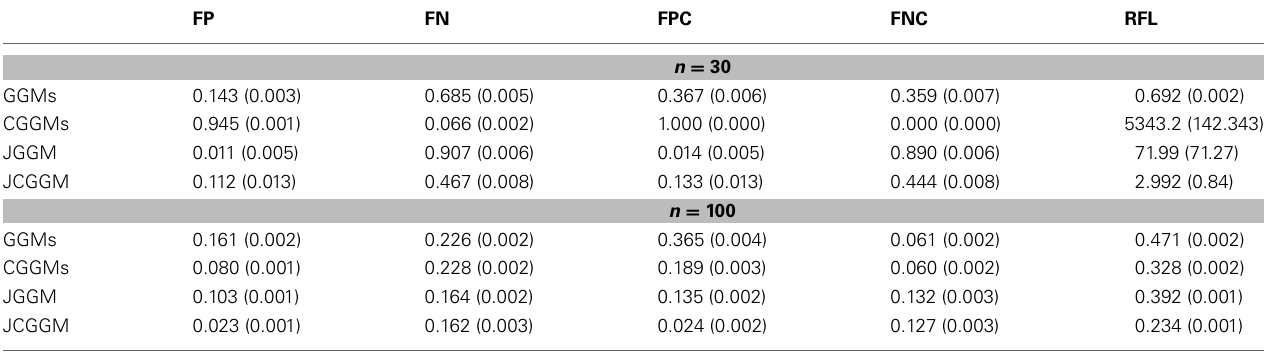
Table 2 | Results for Case 2.